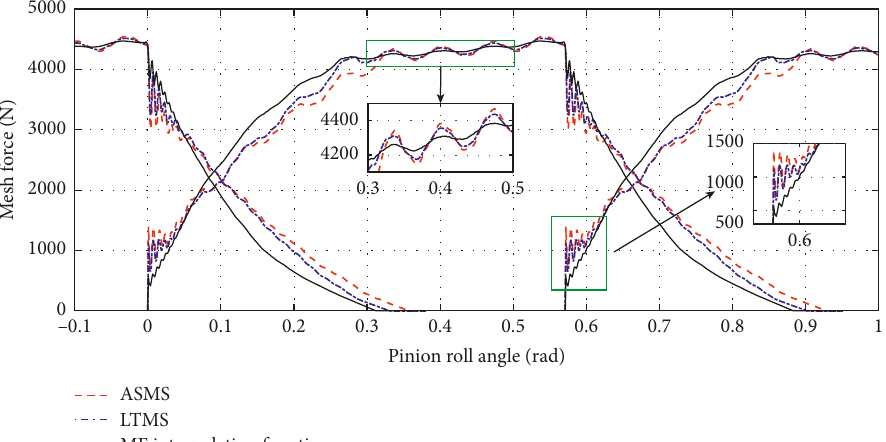
Figure 21: Time histories of DMF per tooth pair estimated by the approaches using the ASMS, LTMS, and mesh force interpolation function at the mesh frequency of 50 Hz and 300Nm torque